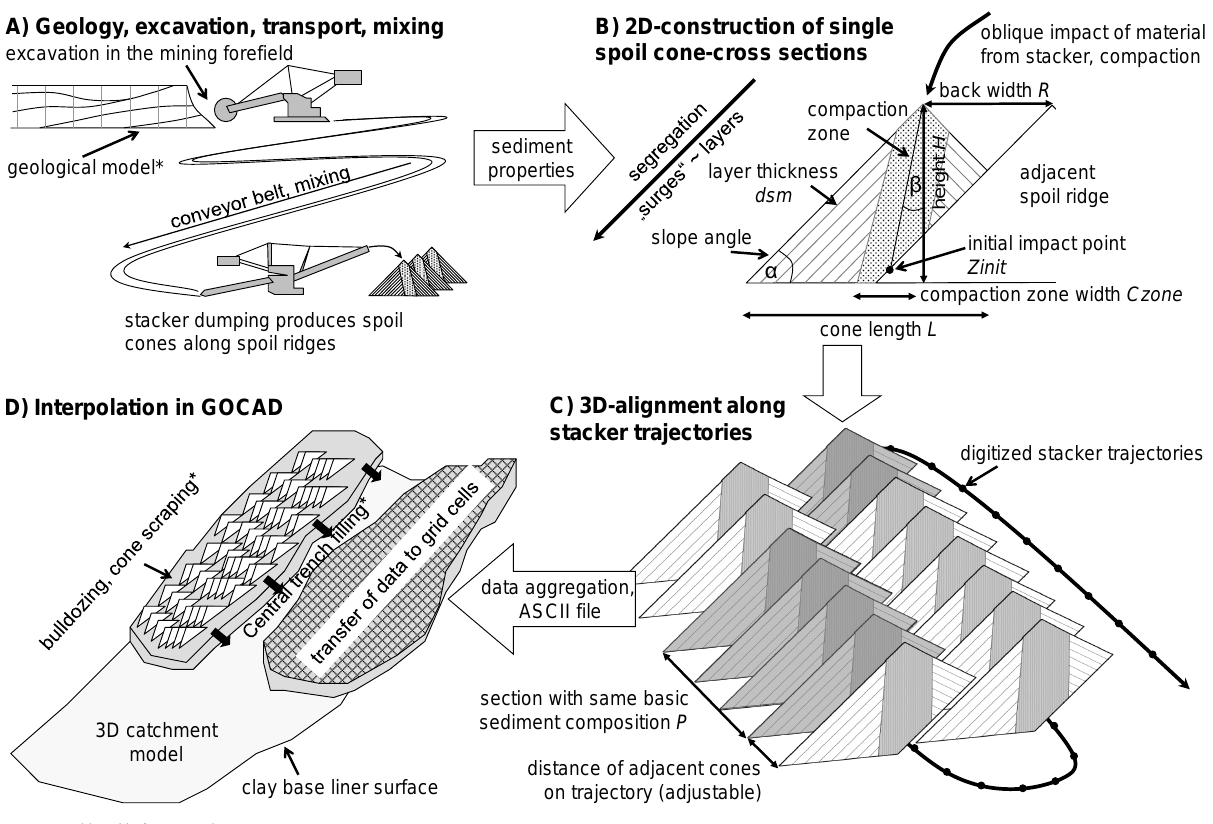
Fig. 4. Conceptual model of the catchment construction steps: (A) modelling of the geological conditions at the excavation site and material transport (not yet included). (B) Relevant parameters and processes considered for spoil cone construction. (C) 3-D-configuration of spoil cone cross sections. (D) Incorporation of the structure generator data in the gridded catchment model and inclusion of bulldozing and cone dcraping processes (not yet